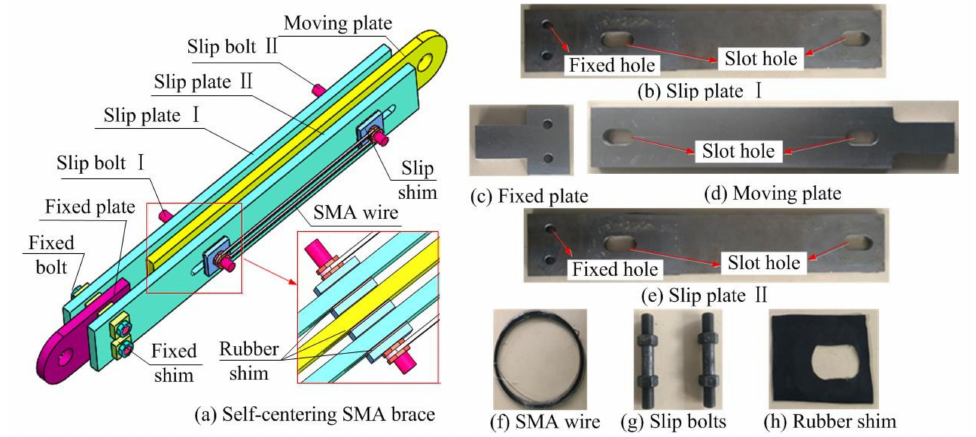
Figure 1. Schematic diagram of self-centering SMA brace.